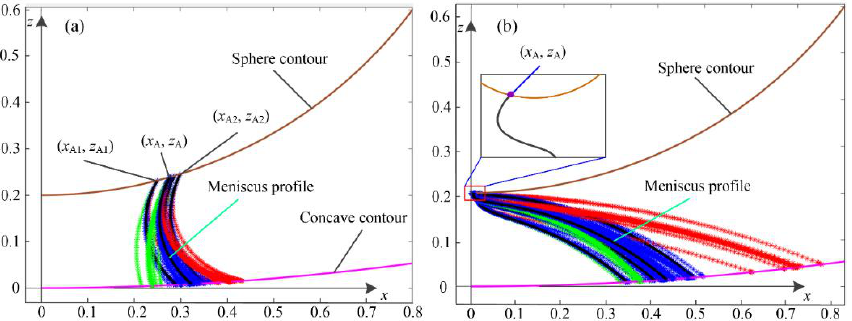
Figure 2. Double iterative processes of meniscus profiles: ( a ) stable solution; ( b ) unstable solution.